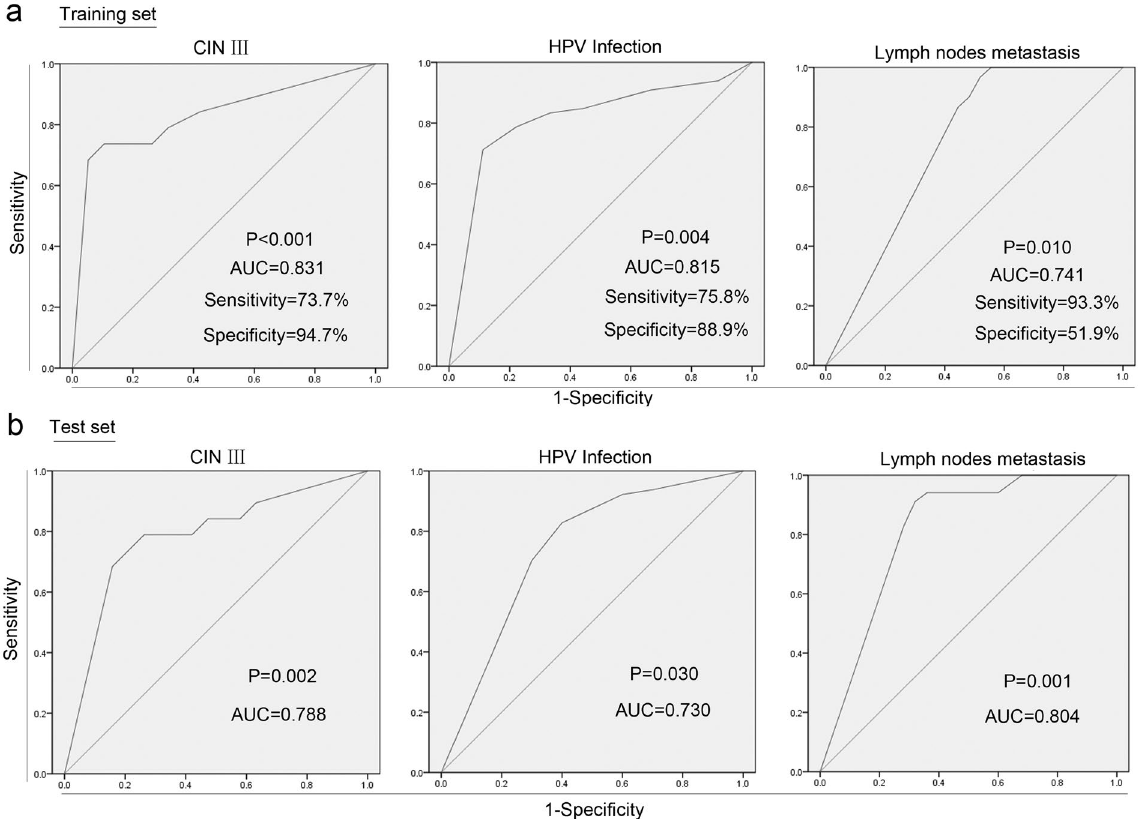
Figure 4. ROC curves for evaluating the diagnostic value of MEG3 methylation in plasmas. CIN III (included their match healthy participants) and cervical cancer patients were divided into training set and test set randomly and averagely. Both values of training set ( a ) and test set ( b ) fell in the fair to good range, thus presenting an well diagnostic power to premalignant lesion (CIN III), HR-HPV infection and lymph node metastasis.